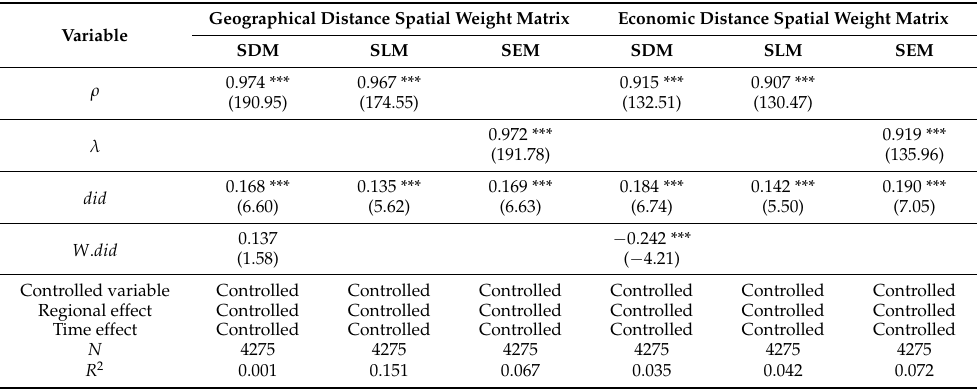
Table 10. Estimated results of spatial DID models with different weight matrices.